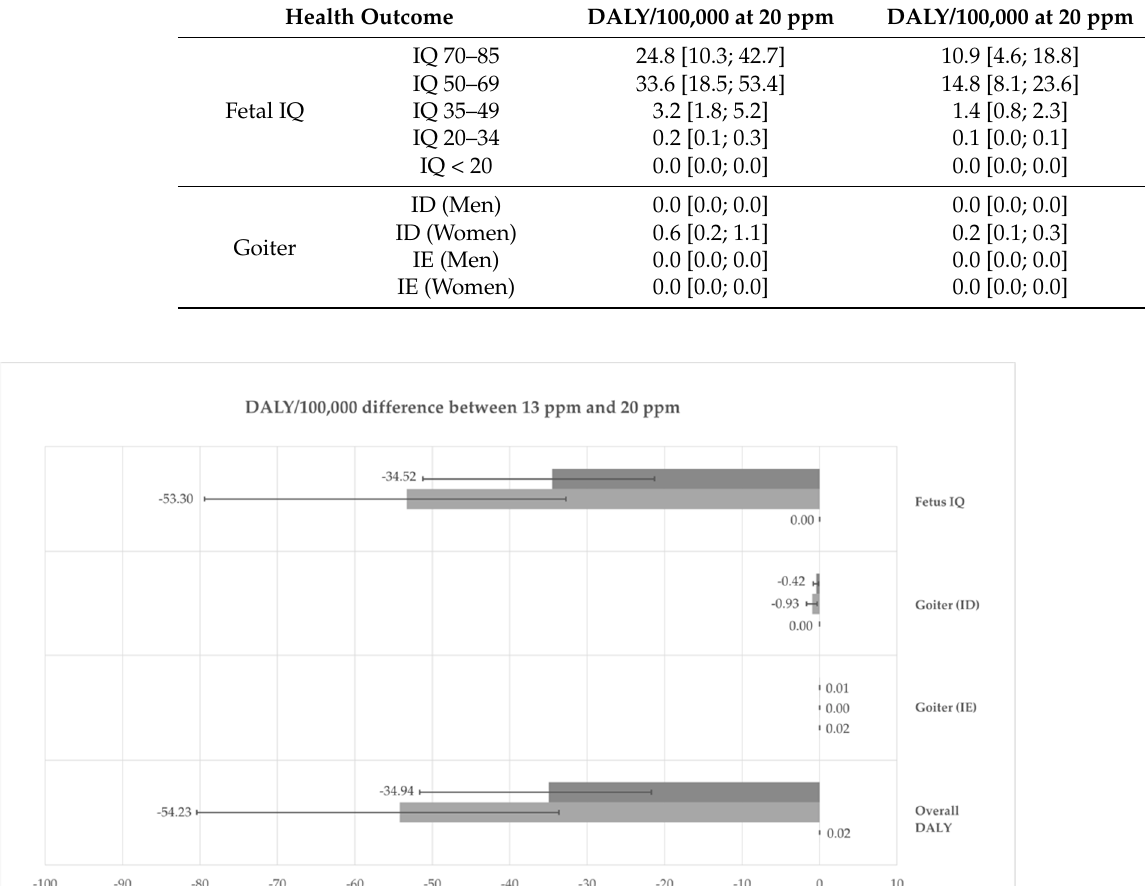
Table 6. Annual DALY per 100,000 for each health effect at fortification levels of 13 and 20 ppm.